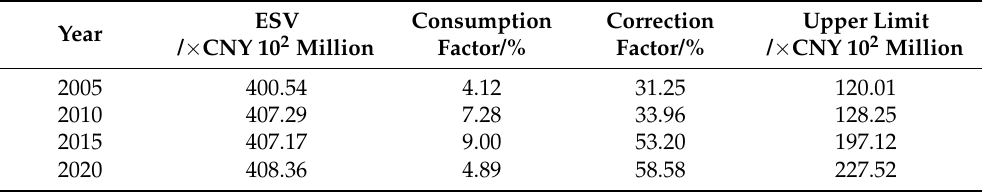
Table 4. Upper limit of eco-compensation standard based on ESV.